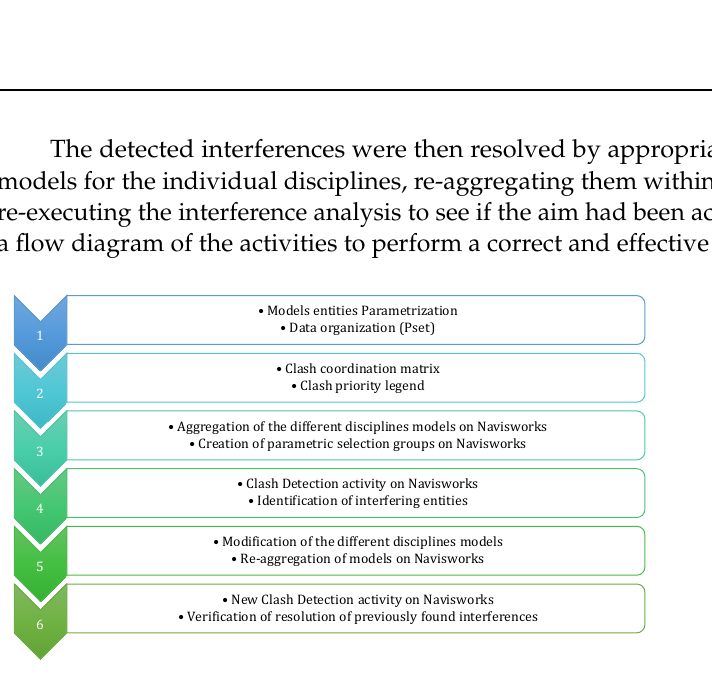
Figure 15. Activity workflow for an effective Clash Detection.